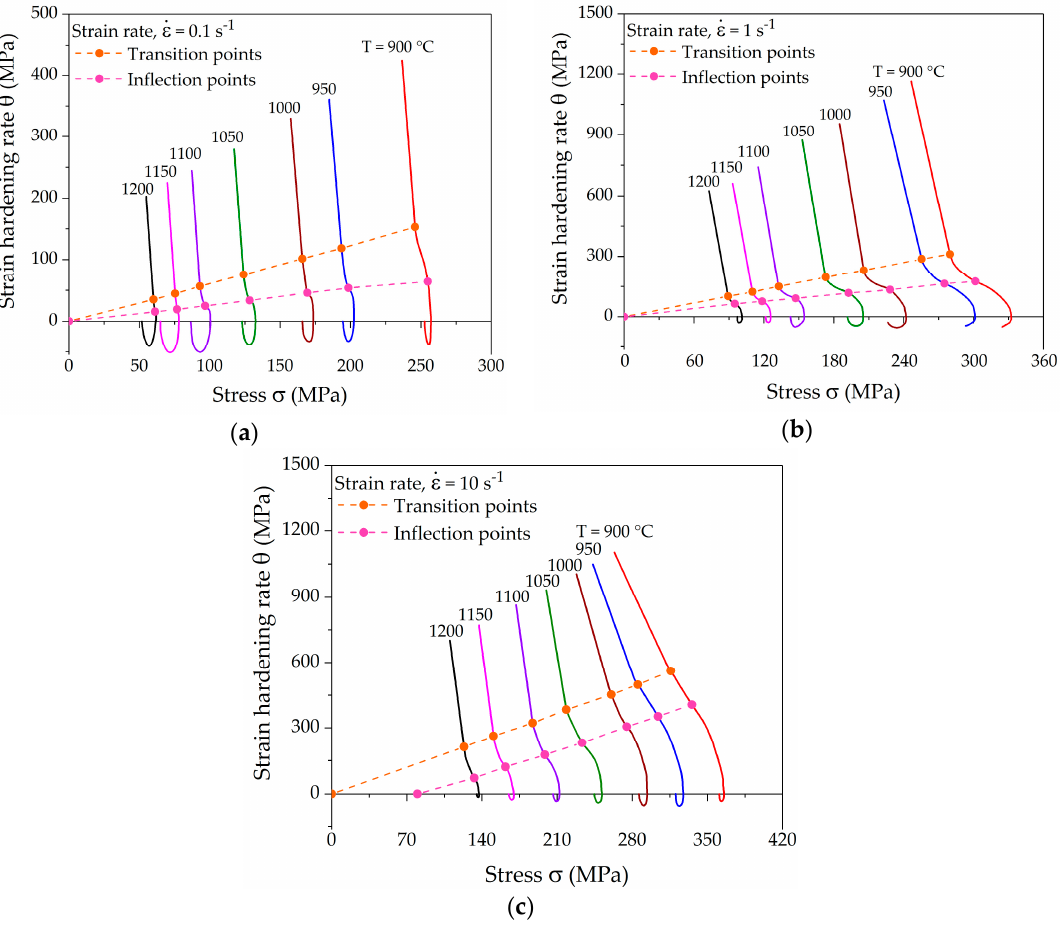
Figure 5. Characteristic strain-hardening rate curves at different temperatures and strain rates of ( a ) 0.1 s − 1 ; ( b ) 1 s − 1 ; and ( c ) 10 s − 1 showing a linear shift of the transition and inflection points.